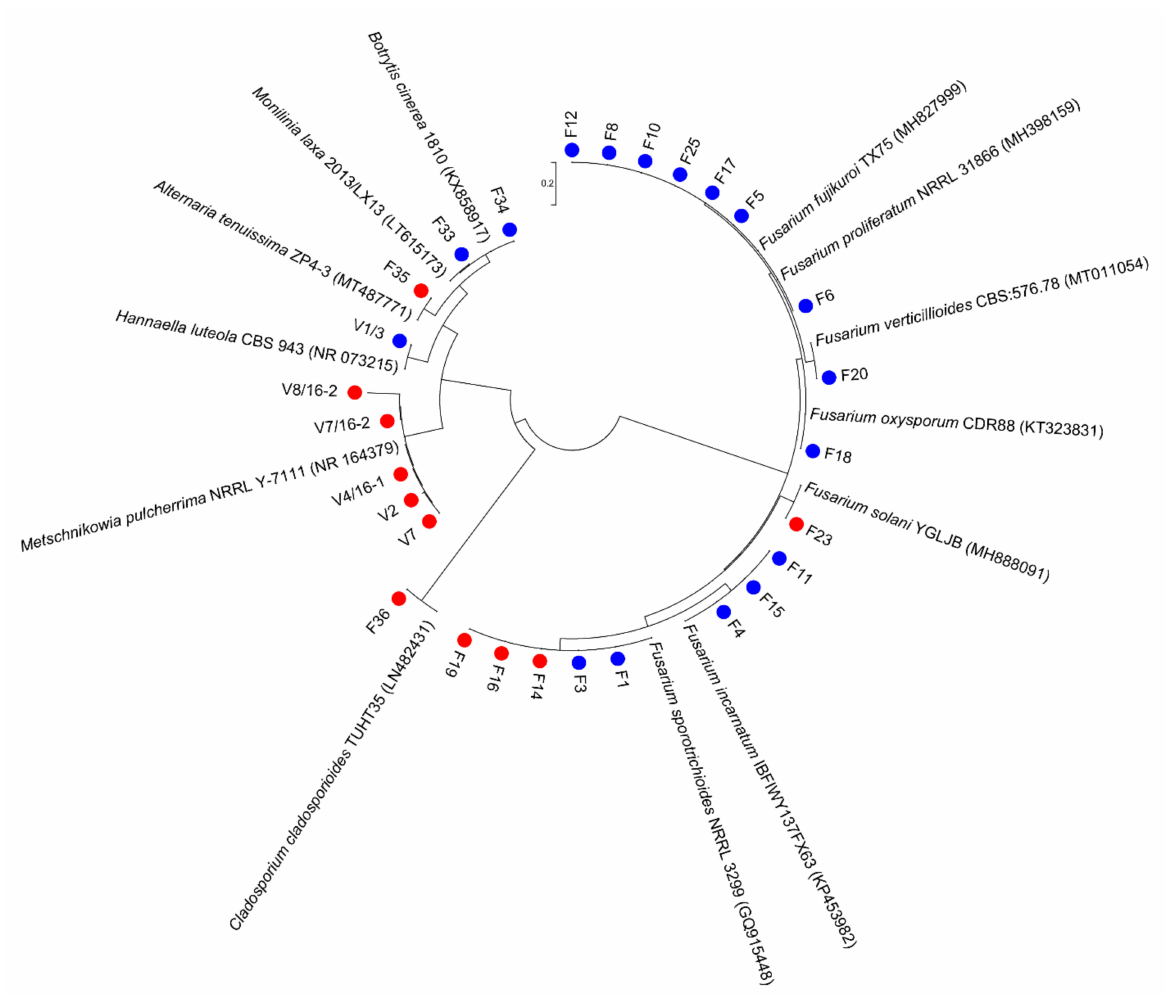
Figure 2. Phylogenetic relationships of fungal isolates from the ‘Williams’ pear variety in two pheno- logical stages (May • and July • ). The phylogenetic tree was constructed by the maximum likelihood method using the Kimura two-parameter